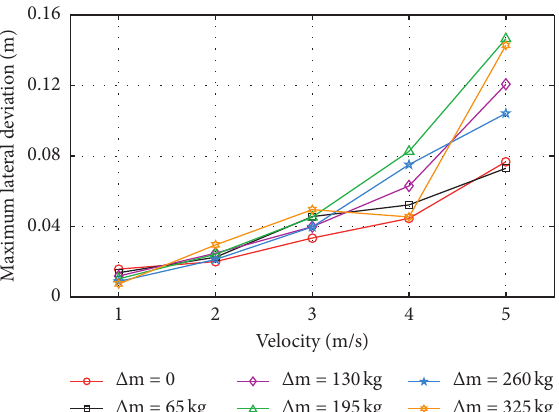
Figure 8: Variations of maximum lateral deviation of the vehicle controlled against vehicle mass under different vehicle velocities.